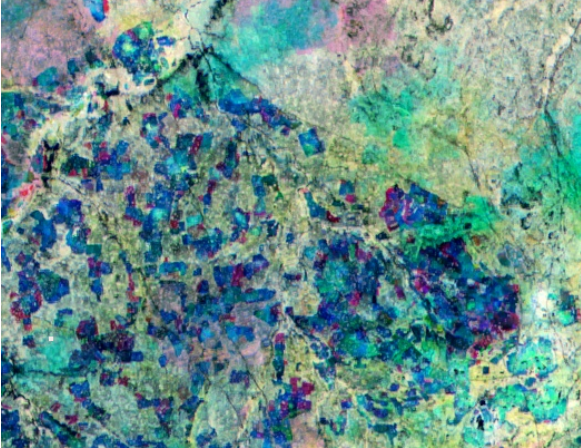
Figure 2: Example of cropland visualised by 3 Period Timescan in the Niassa Pastoral Zone